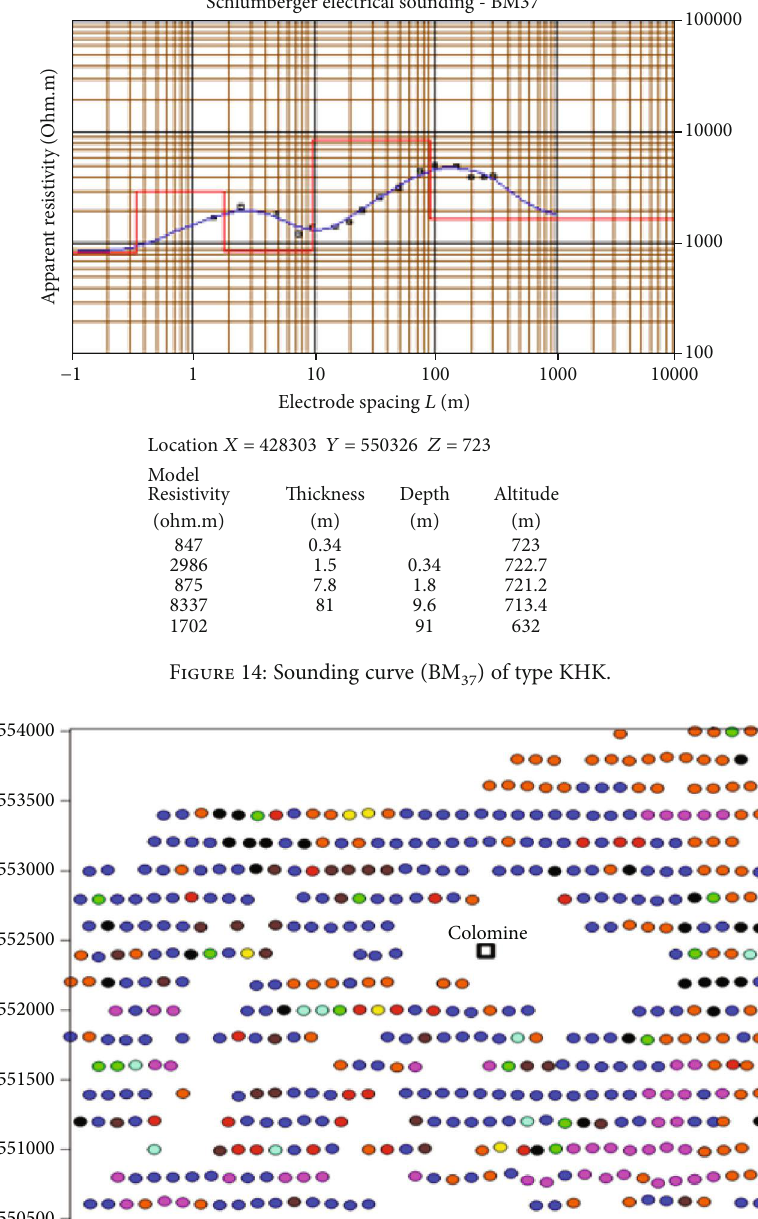
Figure 15: Map of curve types of the Colomine